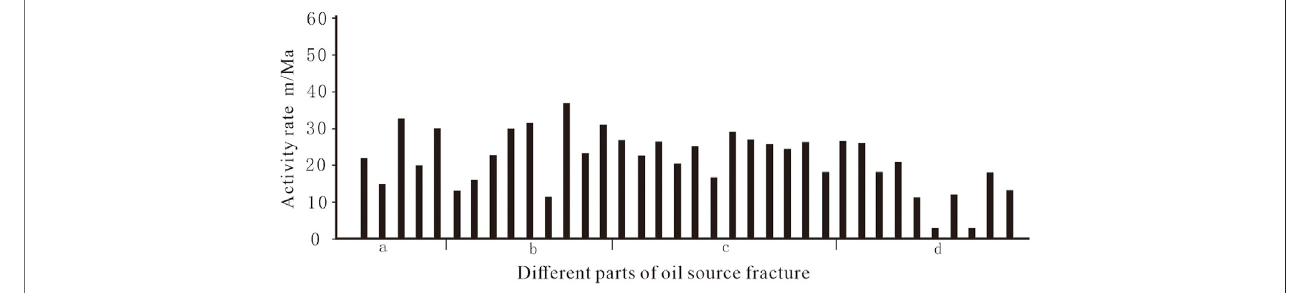
FIGURE 3 | Schematic diagram of determining favorable positions for transporting oil and gas by source-fault con fi guration during fault active period.